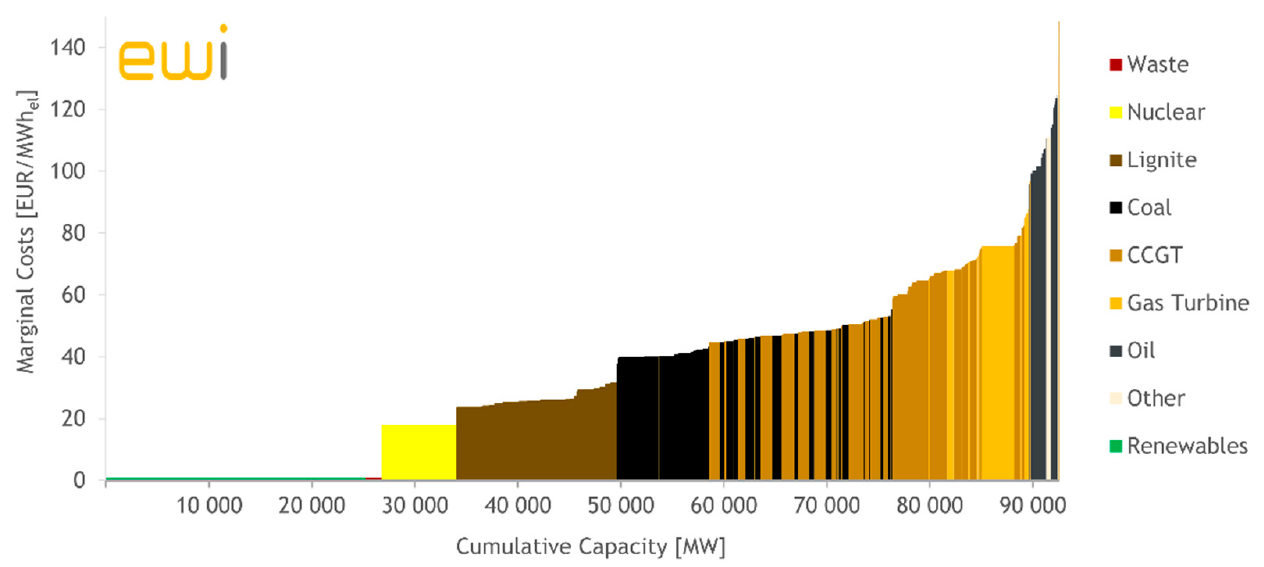
Figure 5. Merit Order of power generation in Germany in 2018 [26].